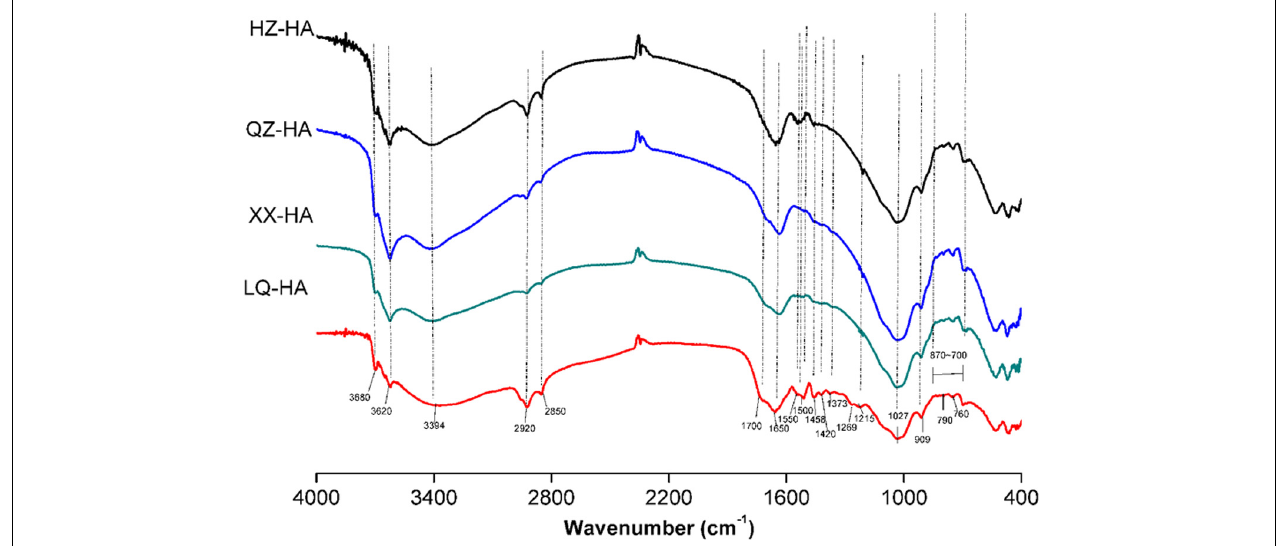
FIGURE 2 | Fourier transform infrared (FTIR) spectra of HAs extracted from four different sediments. Abbreviated names of HAs are the same as those presented in Table 1 .